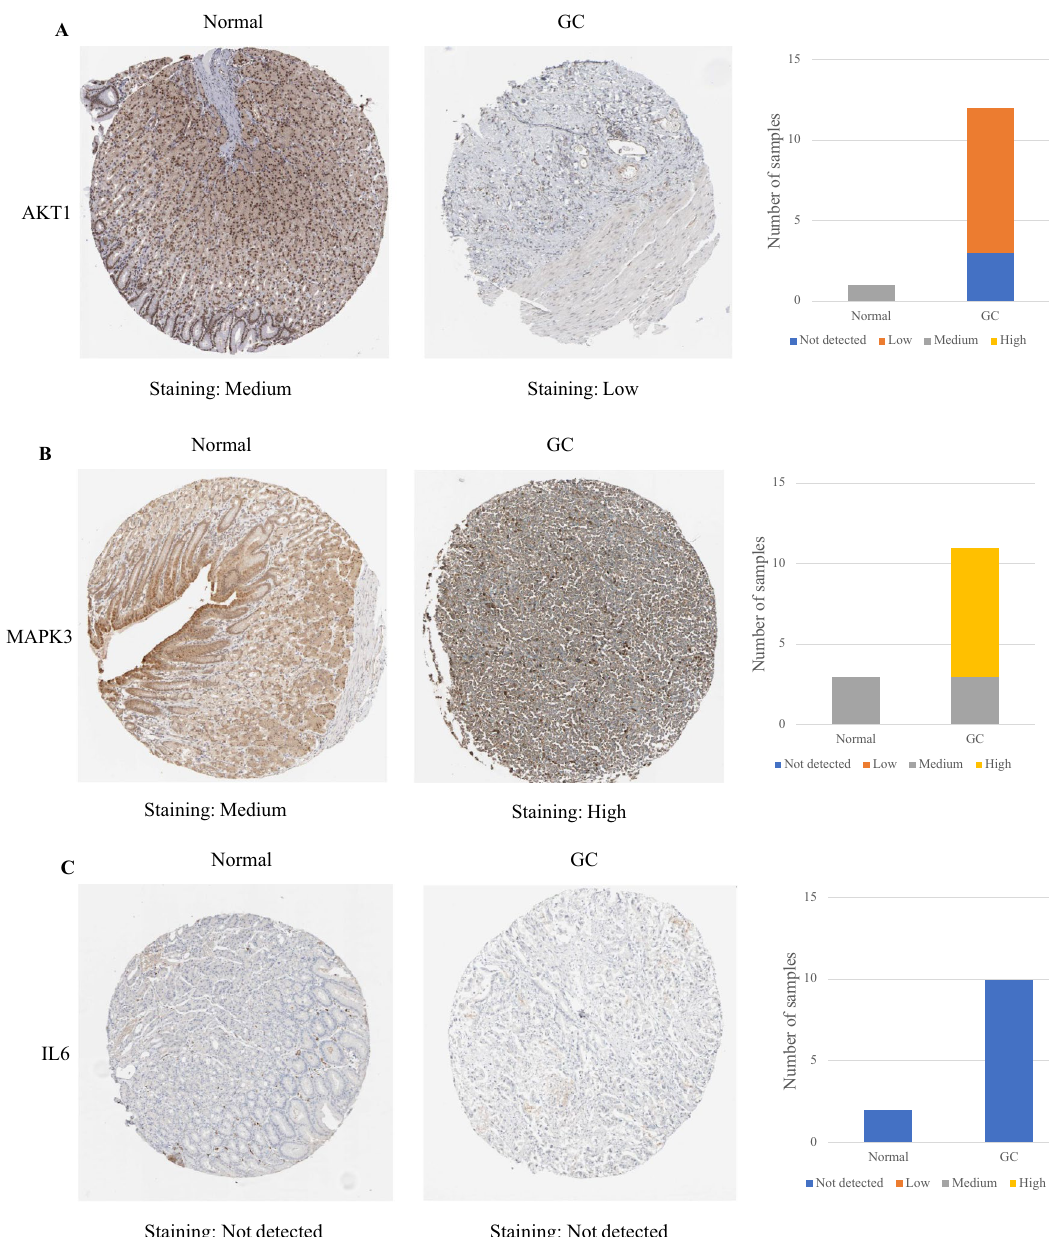
Figure 12. IHC of hub targets in the HPA. Representative immunohistochemistry images of ( A ) AKT1, ( B ) MAPK3, ( C ) IL6, ( D ) MAPK1, ( E ) EGFR, ( F ) SRC, ( G ) TNF, ( H ) CXCL8, ( I ) CASP3, and ( J ) APP in GC and noncancerous stomach tissues. The staining strengths were annotated as Not detected, Low, Medium, and High. The bar plots indicate the number of samples with different staining